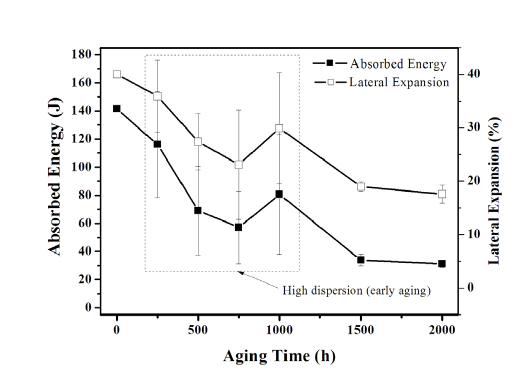
Figure 4. Values of toughness and lateral expansion of the material studied under several aging conditions at 600